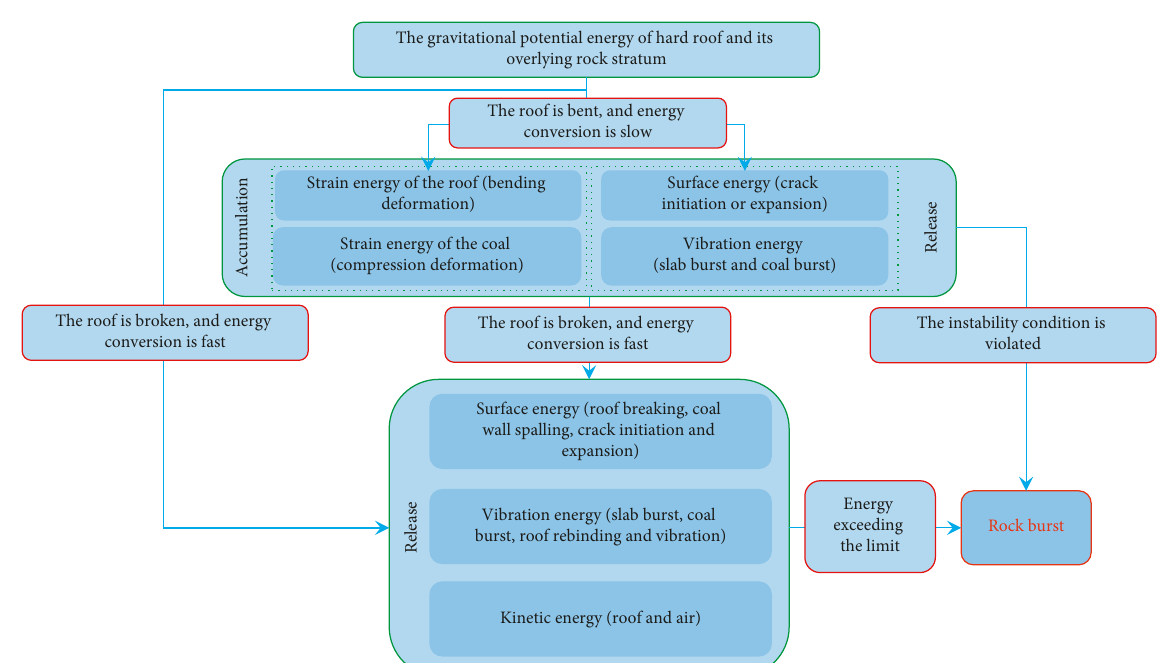
Figure 2: Hard roof exposure and breakage failure development